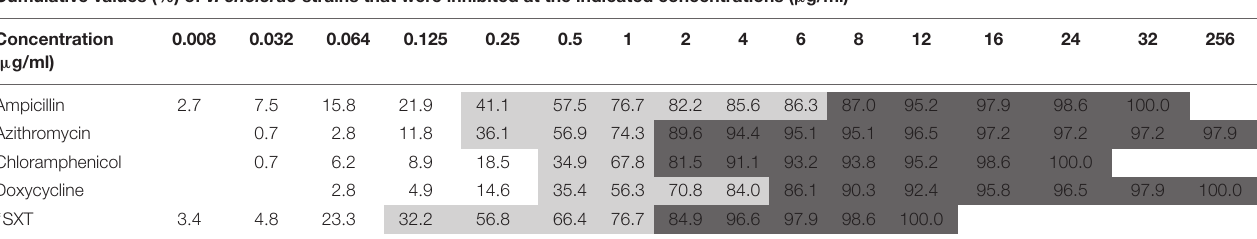
TABLE 2 | Cumulative distribution of the MIC values for all the studied strains. Cumulative values (%) of V. cholerae strains that were inhibited at the indicated concentrations ( µ g/ml) ∗∗ Concentration ( µ g/ml)